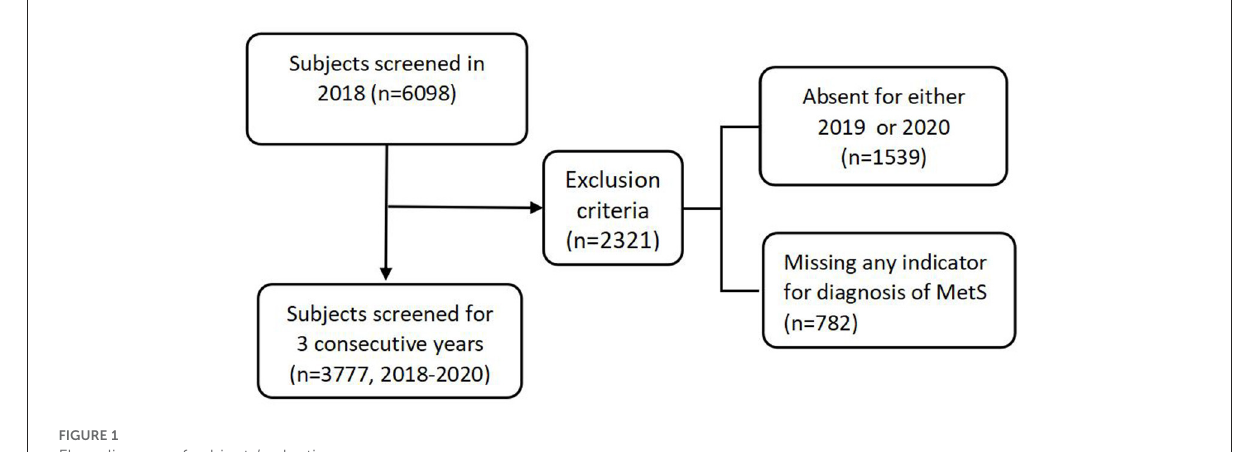
FIGURE1 Flow diagram of subjects’ selection.